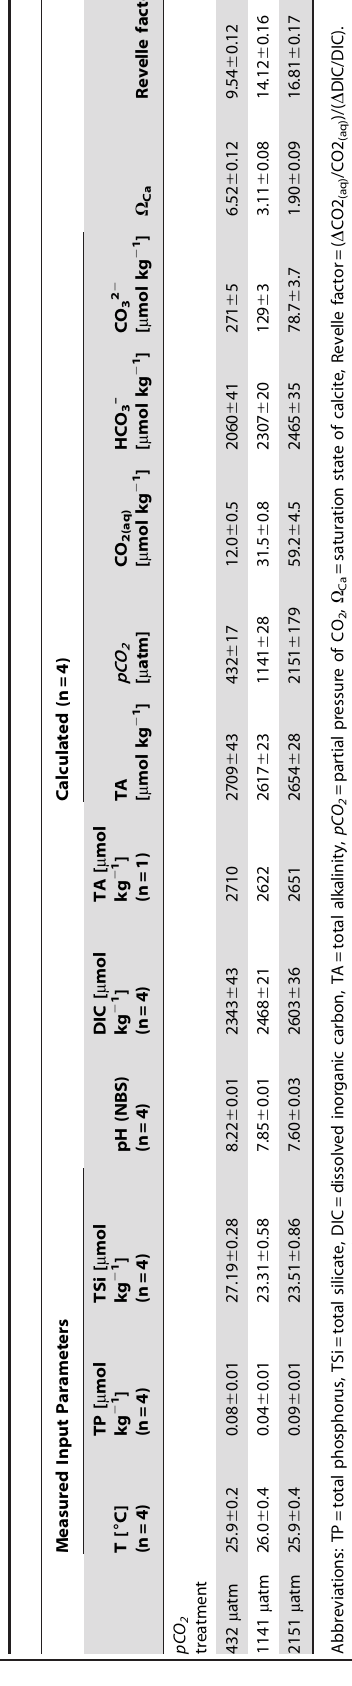
490 nm; dichroic mirror FT510; emission LP515 nm) filter